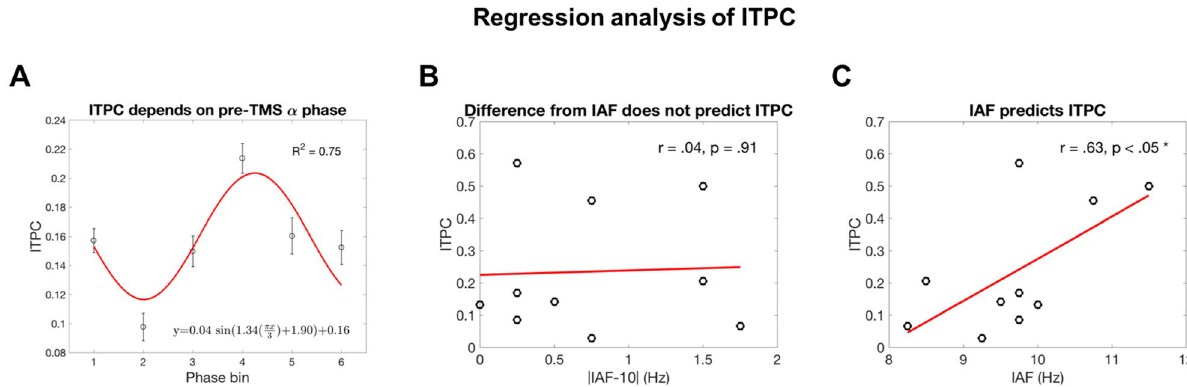
Figure 6. Regression analysis of ITPC in the rhythmic-active stimulation condition. The time window of ITPC is 0.205–0.705 s, the same as the significant windows in Table 1. ( A ) ITPC depends on pre-TMS α-phase (200 ms before the first pulse). Each point is the average of 510 samples (10 participants × 51 time points). The error bars represent ± 1 SEM. This ~ 1 period cyclic pattern suggests that the congruency between TMS and the phase of ongoing α oscillations determines the effectiveness of entrainment. Phase bin #2 roughly corresponds to the ~ 10 Hz ERP peak and phase bin #5 to the trough. Note that due to conduction time the phase measured on the scalp does not indicate the exact phase of the oscillator in the brain. ( B ) Difference from IAF does not predict ITPC. The absolute difference between IAF and the entraining frequency does not predict ITPC during and after stimulation. ( C ) IAF predicts ITPC. IAF positively correlates with ITPC during and after stimulation. See text for